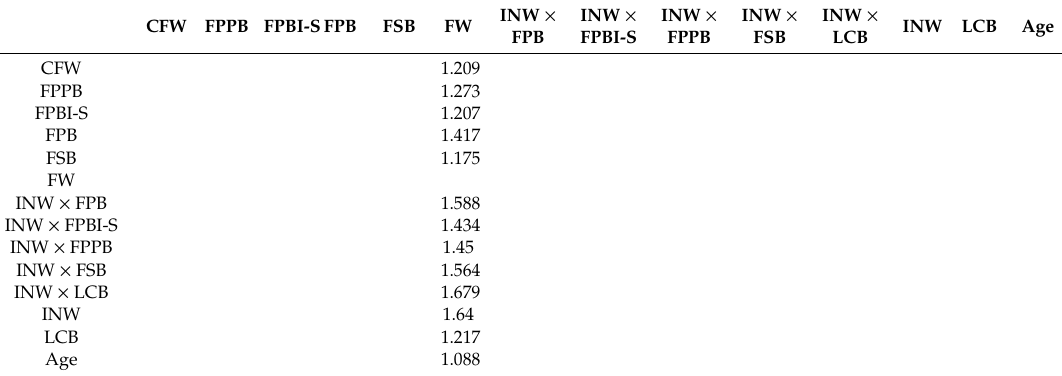
Table 6. Collinearity statistics (Variance Inflation Factor (VIF))—inner VIF values.